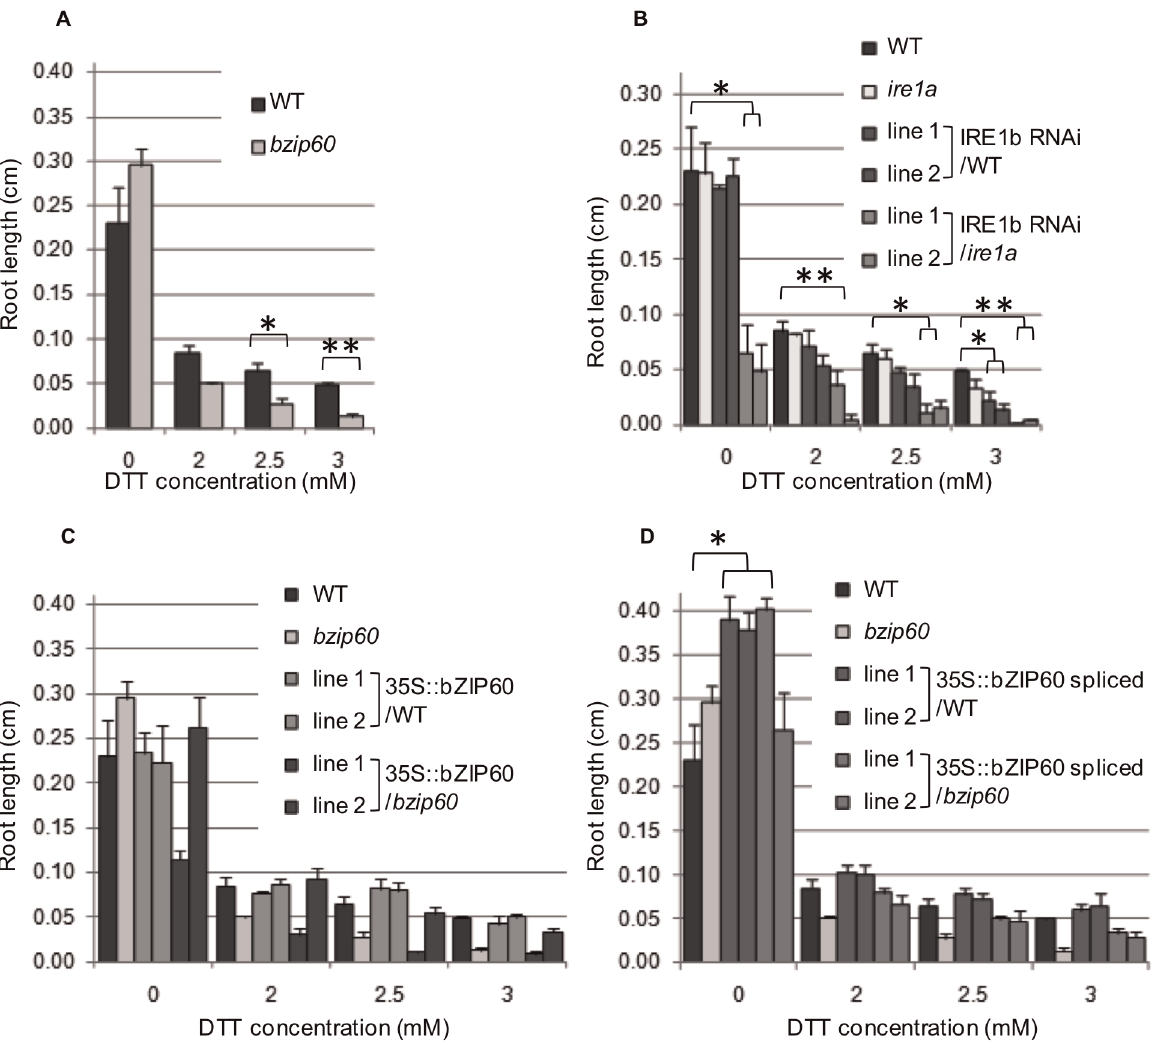
Figure 6. Root growth in response to DTT treatment in mutants and transgenic lines. Root length measured three d after sowing on MS medium supplemented with indicated concentrations of DTT in WT, mutant (A), IRE1b RNAi lines (B), lines over-expressing bZIP60 full-length (C), and lines over-expressing bZIP60 spliced (D). Values correspond to averages of biological replicates and corresponding standard errors. Student’s t-tests were performed to assess the significance of the results for the different lines compared to WT. Statistically significant comparisons are indicated on the graphs with * and ** denoting respectively a p-value # 0.05 and 0.01.